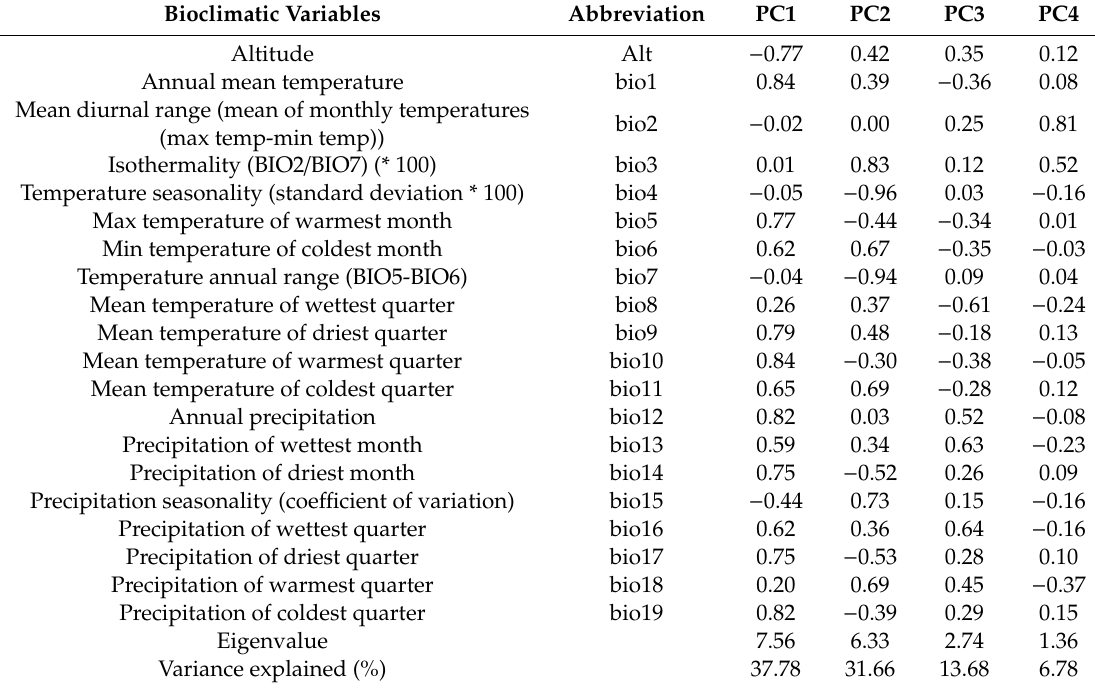
Table 4. Pearsoncorrelationcoefficientsbetweenclimaticvariablesandthefirstfourprincipalcomponents, eigenvalues, and explained